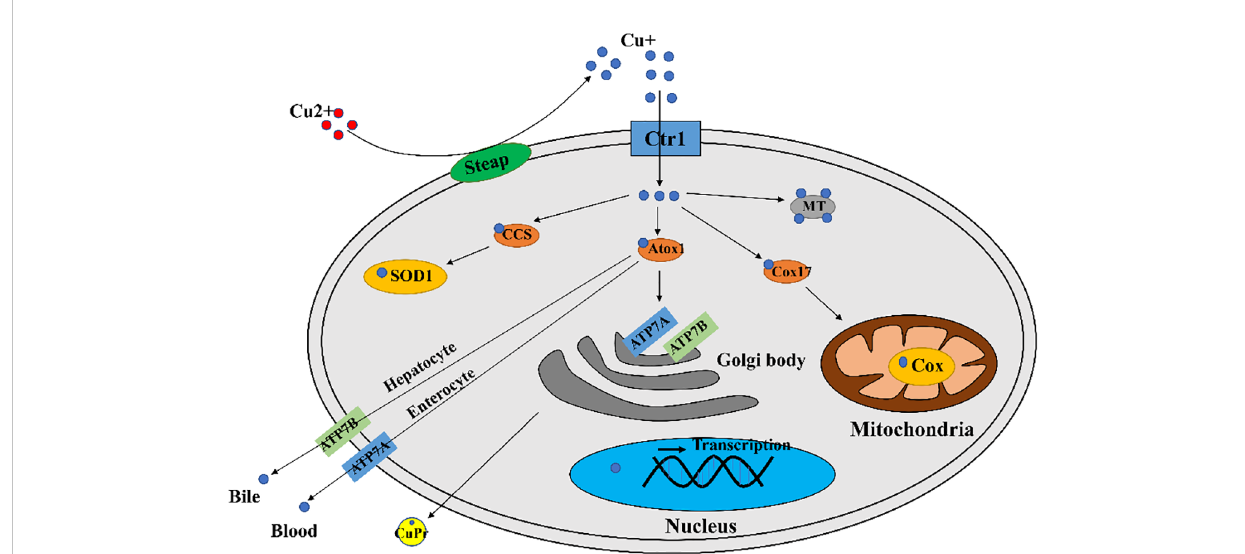
FIGURE 1 A diagram of cellular copper transport and metabolism. Extracellularly, copper exists as Cu 2+ . The cellular reductases protein family Steap proteins (mainly Steap 2/3/4) reduce Cu 2+ to Cu + , which is transported into the cell via Ctr1, and a fraction of Cu + is targeted to cytosolic SOD1 by the copper chaperone CCS to scavenge free radicals. A fraction of Cu + is delivered by the copper chaperone Cox17 to the mitochondrial Cox to generate ATP. A portion of Cu + is delivered to ATP7A/B of the trans Golgi network by the copper chaperone Atox1, which promotes cuproproteins (CuPrs) assembly and secretion. The remaining excess Cu + is sequestered by metallothionein (MT). There are copper sensors in the nucleus that respond to changes in copper concentration through regulating MT1 and MT2 gene transcriptions. In enterocytes, ATP7A migrates to the plasma membrane to pump Cu + into the blood. In hepatocytes, ATP7B pumps Cu + into the